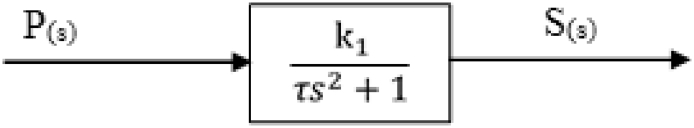
Transfer function block for spray tip penetration length.